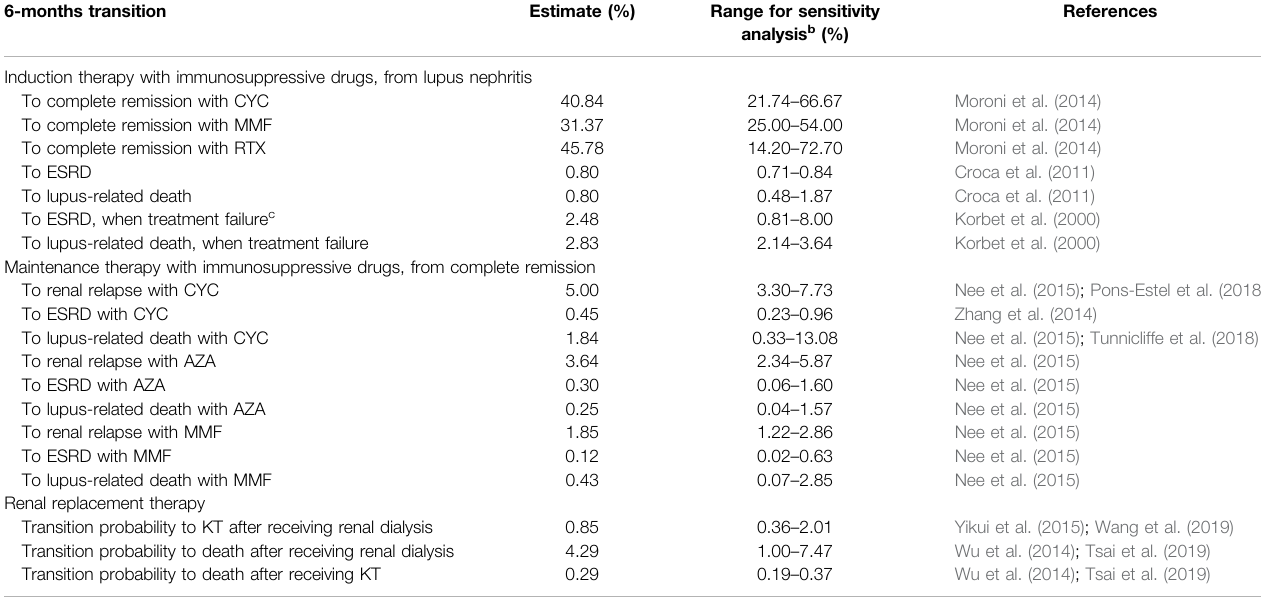
TABLE 1 | Transition probabilities related to disease progress and different treatments a